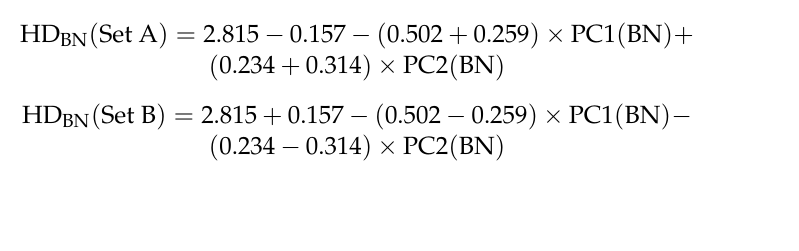
Figure 16. The residuals, stratified on test sets (red for set ( A ) and blue for set ( B )), from ( A ) modeling hardening depths using principal components only (model i) and ( B ) the improved model (ii).